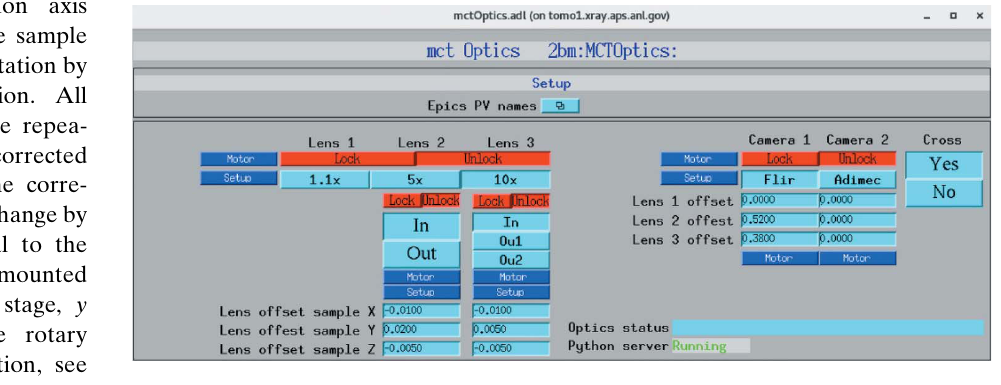
Figure 3 Control of the Optique Peter microscope system with three lens and two detector change. Once the sample x , y , z and detector rotation offsets are measured they are entered in the mctOptics setup screen as Lens offset sample X , Y , Z and Lens 1,2,3 offset. The instrument operator can change lens by pressing the lens selector button 1.1 (cid:7) , 5 (cid:7) , 10 (cid:7) while keeping the rotation axis aligned and locked at the same 3D sample